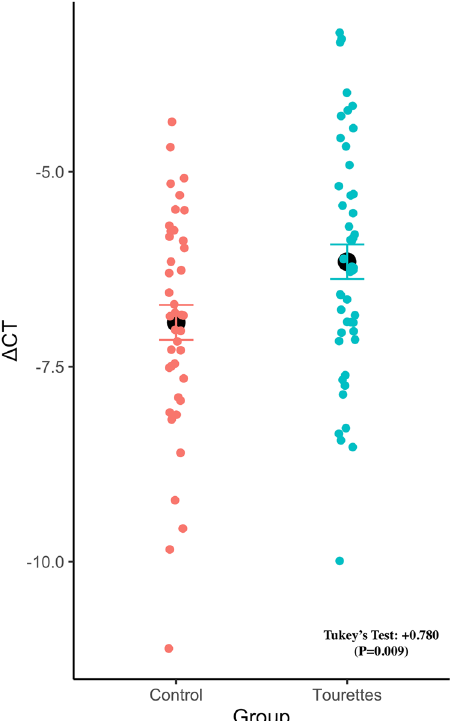
Fig. 2 FLT3 RNA Expression differences between Tourette ’ s Syndrome patients and controls in lymphoblastoid cell lines (LCL). TS LCL had higher expression of FLT3 compared to controls after adjusting for plate, sex, and age. The black dot represents the mean of the data and error bars are ±SE.